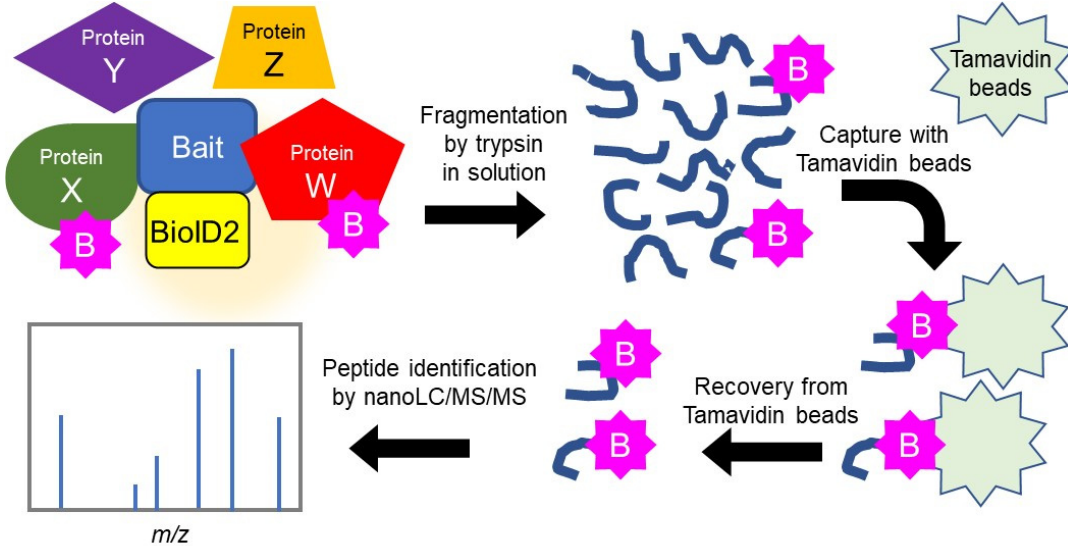
Figure 2. Efficient protein–protein binding analysis using BioID2 and Tamabidine 2-REV beads.